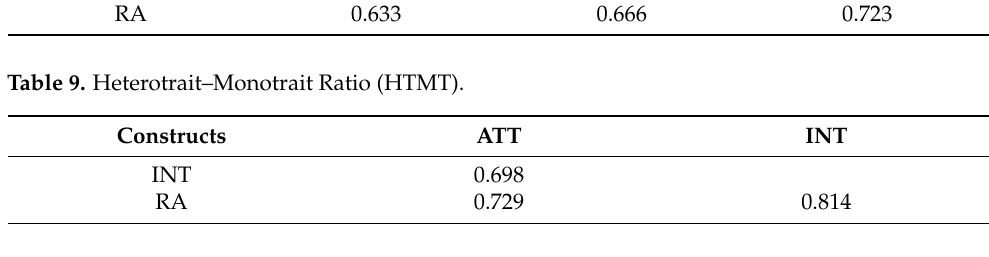
Table 10. Cross loadings among reflective scale